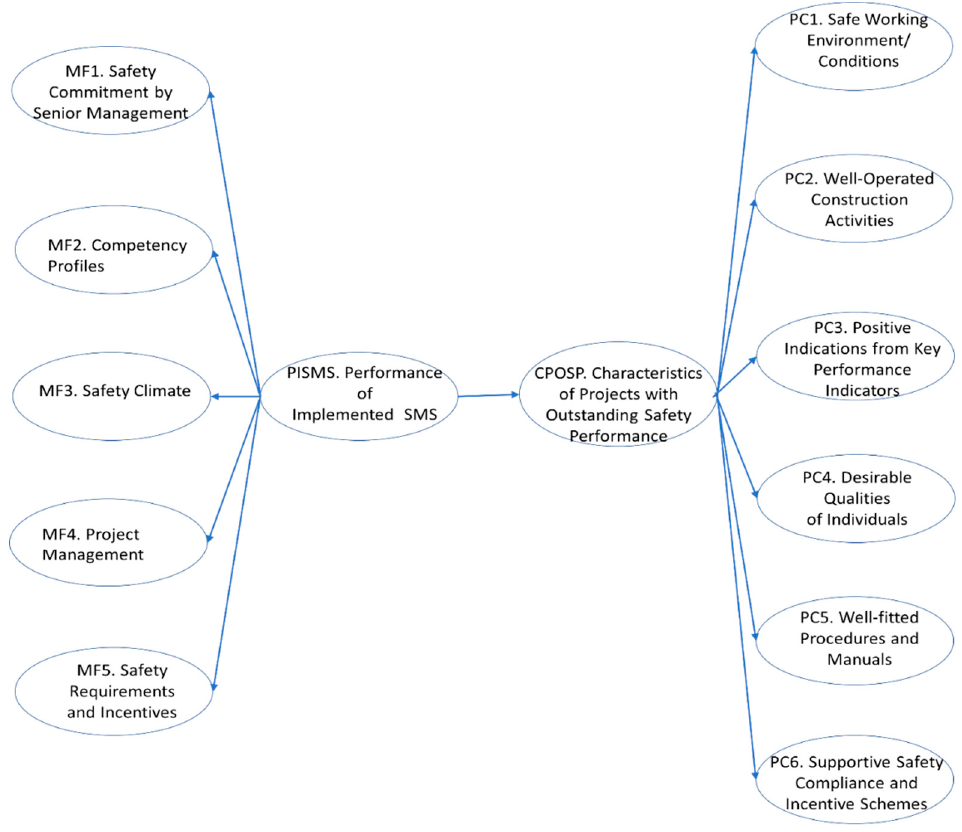
Figure 2. Proposed Structural Model for the Association between Motivation Factor and Project Outcomes.